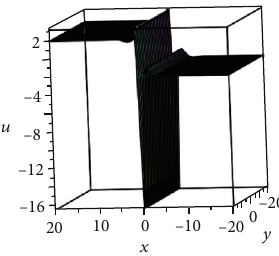
Figure 2: Spatiotemporal structure of solution (11) with the parameter selections a 1 = 1 , a 5 = 1 , and a 7 = 1 .